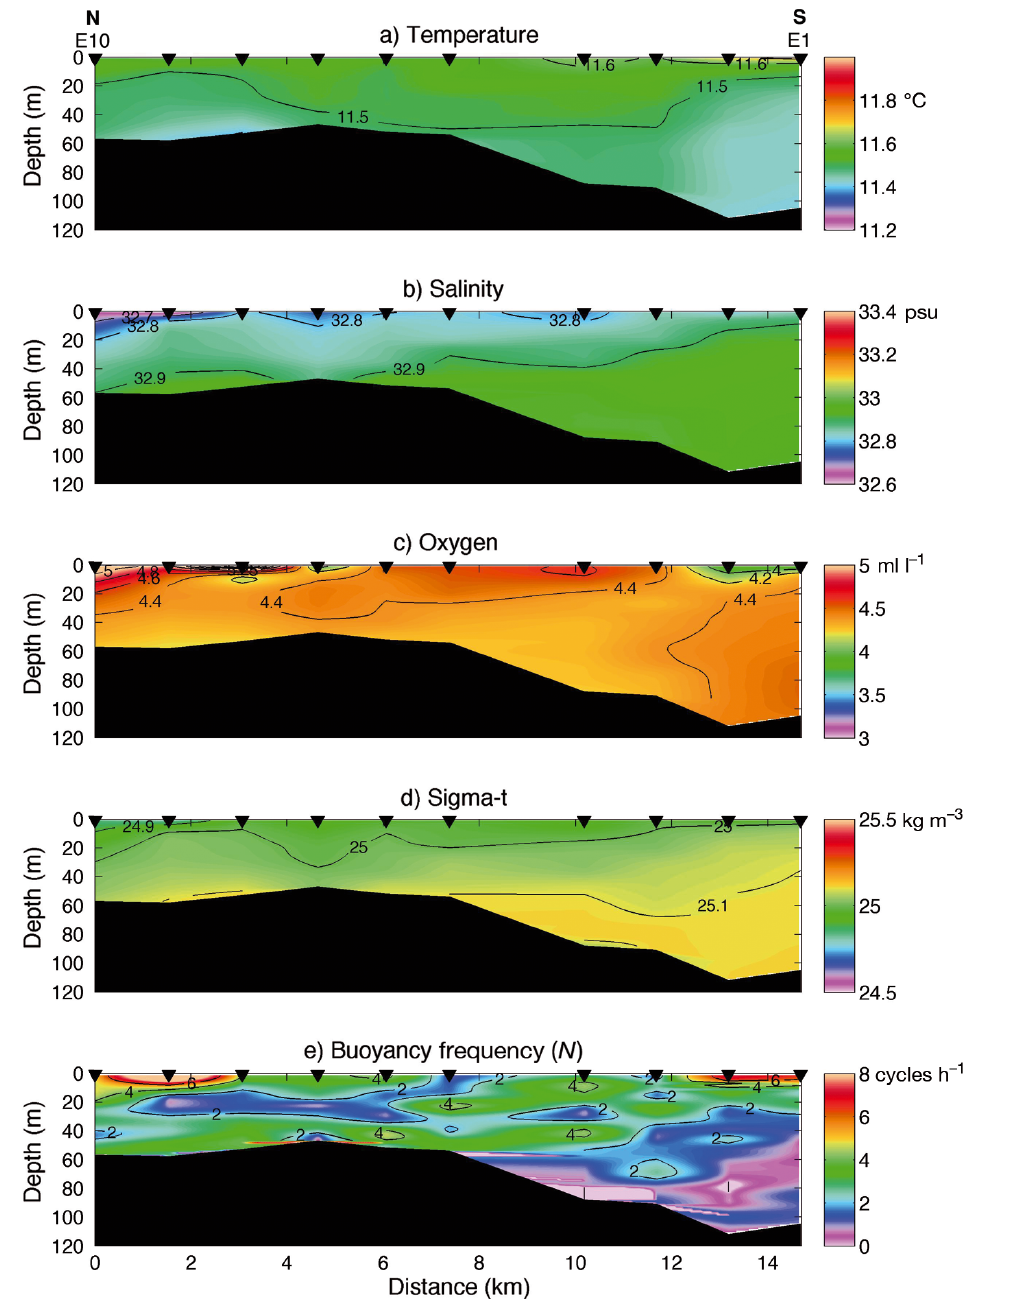
Fig. 10. Hydrographic section along the Caucahue Channel, 17−19 April 2011. The horizontal axis (distance in km) has its ori- gin at Station 10, located in the north arm of the channel. Black triangles on the upper horizontal axis indicate the location of the hydrographic